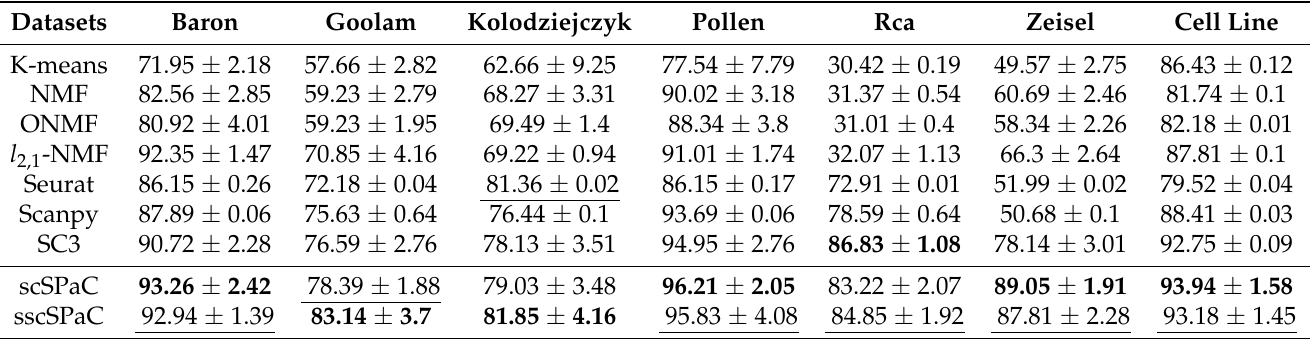
Table 4. Clustering results for purity on real scRNA-seq data. The highest score for each dataset is shown in bold and the second best score is underlined.